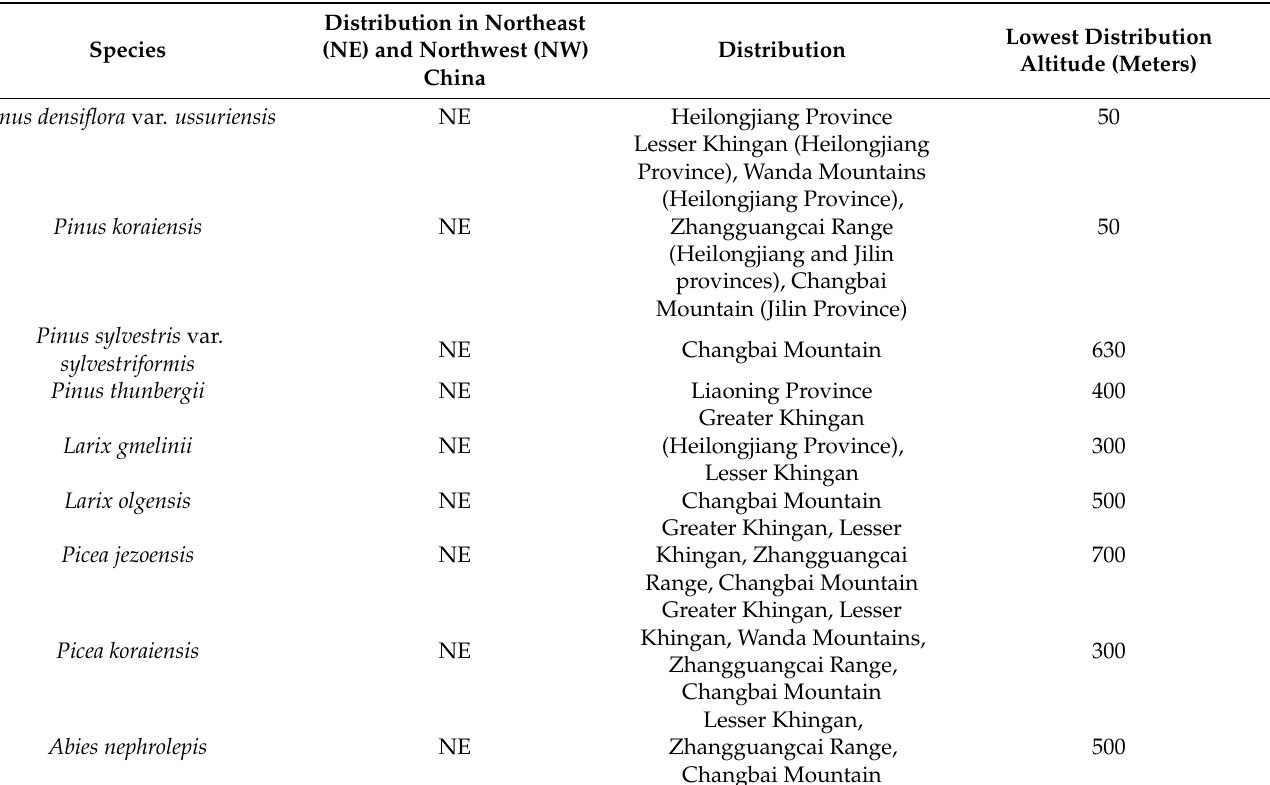
Table 2. Conifer tree species with the lowest distribution at an altitude below 1000 m in Northeast and Northwest